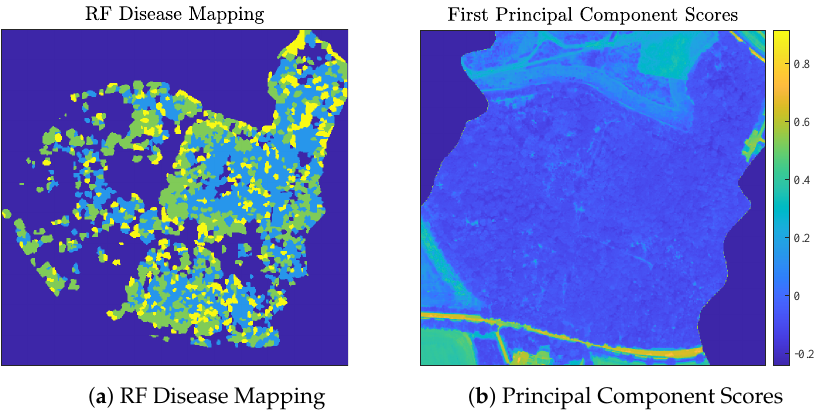
Figure 10. Visualizations of the Madingley HSI. The RF disease mapping is visualized in ( a ) and the Madingley HSI’s first principal component scores are visualized in ( b ). In ( a ), yellow indicates severely-infected ash, green indicates infected ash, and light blue indicates healthy